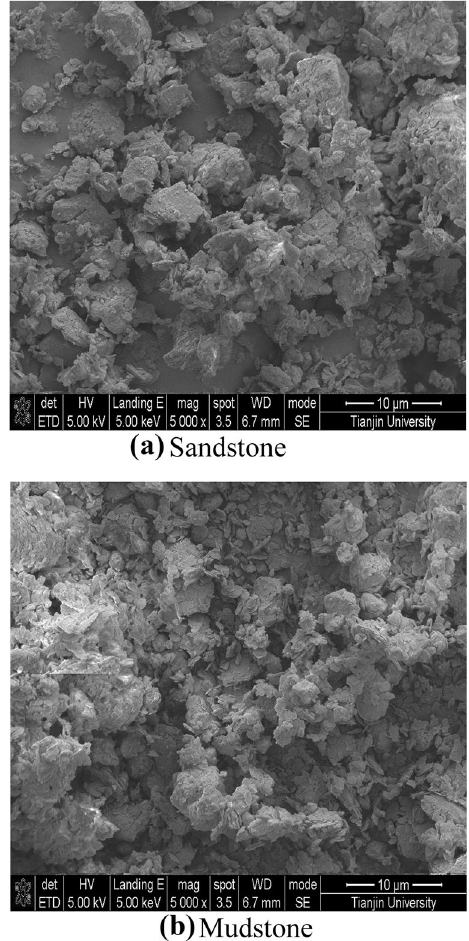
Fig. 4 SEM morphology of rock samples in